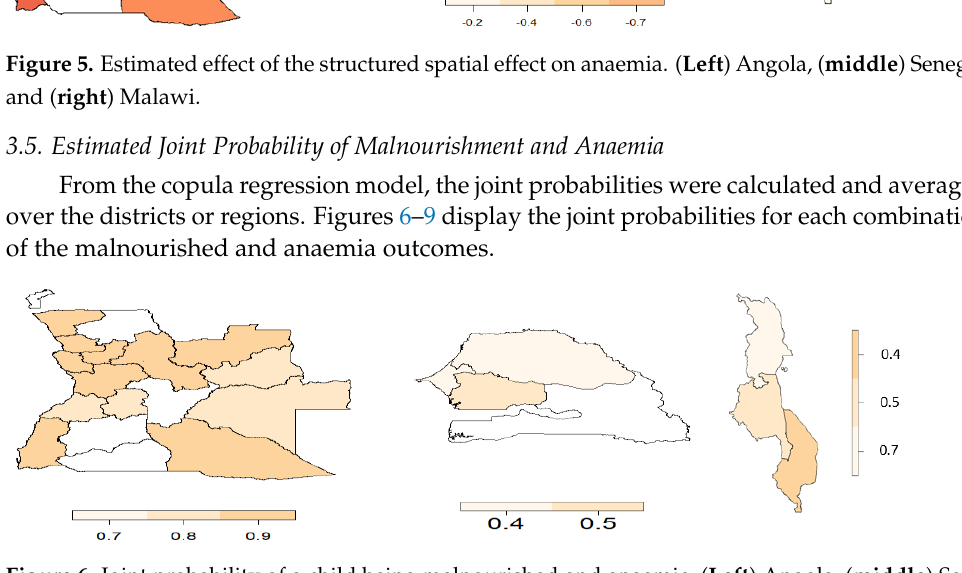
Figure 5. Estimated effect of the structured spatial effect on anaemia. ( Left ) Angola, ( middle ) Senegal, and ( right ) Malawi.